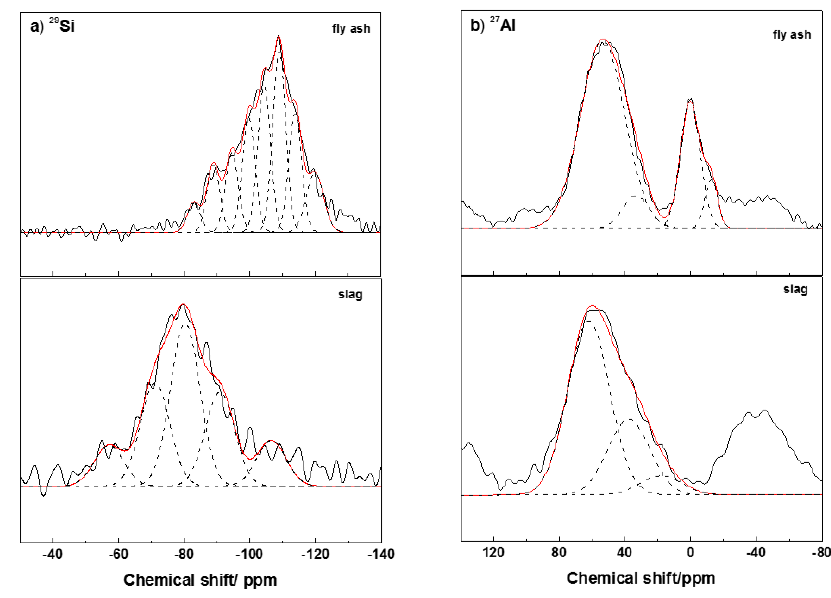
Figure 2. MAS-NMR ( a ) 29 Si; and ( b ) 27 Al spectra of the anhydrous slag and fly ash.